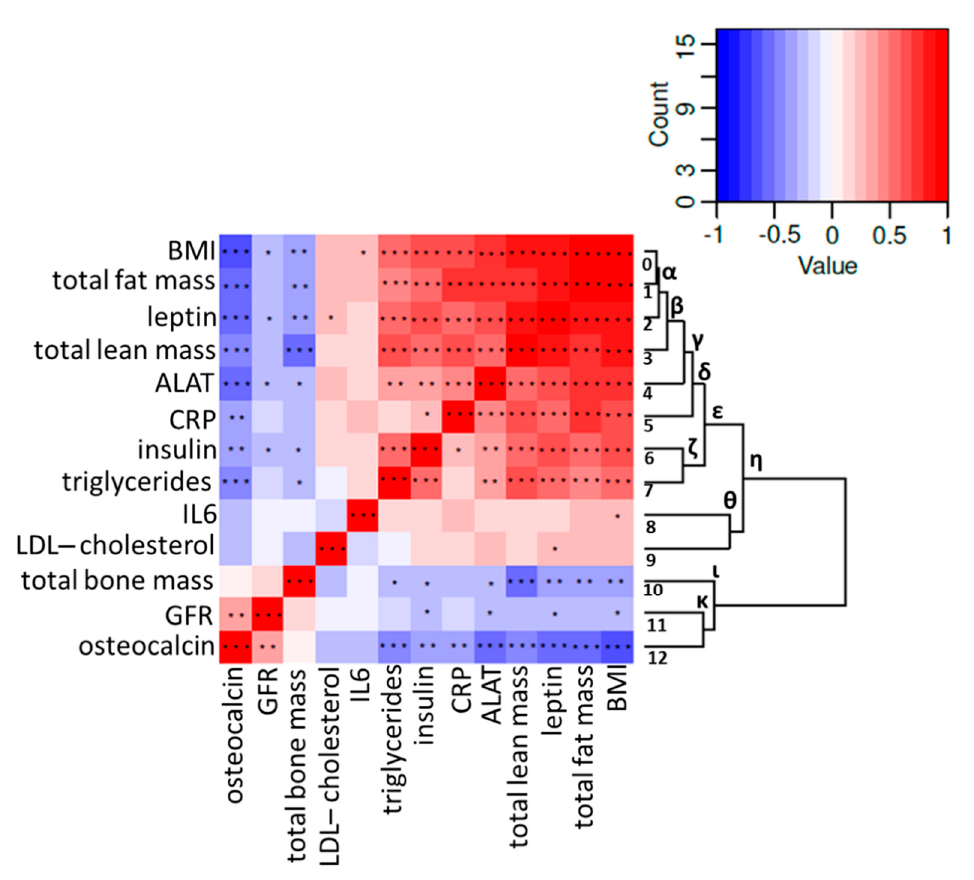
Figure 4. Correlation between OC, metabolic markers, body composition, and inflammation during the 6-month study in both groups. The heatmap ( left ) represents Spearman correlations between relative changes in variables. Colors indicate the correlation coefficient, ranging from blue ( − 1,0) to white (0,0) to red (1,0). Stars represent significant p -values: * p < 0.05; ** p < 0.01; *** p < 0.001. The dendrogram ( right ) indicates the hierarchical relationship between variables. Variables with similar patterns of correlation are clustered together. Numbers indicate chunks, Greek letters indicate clades.